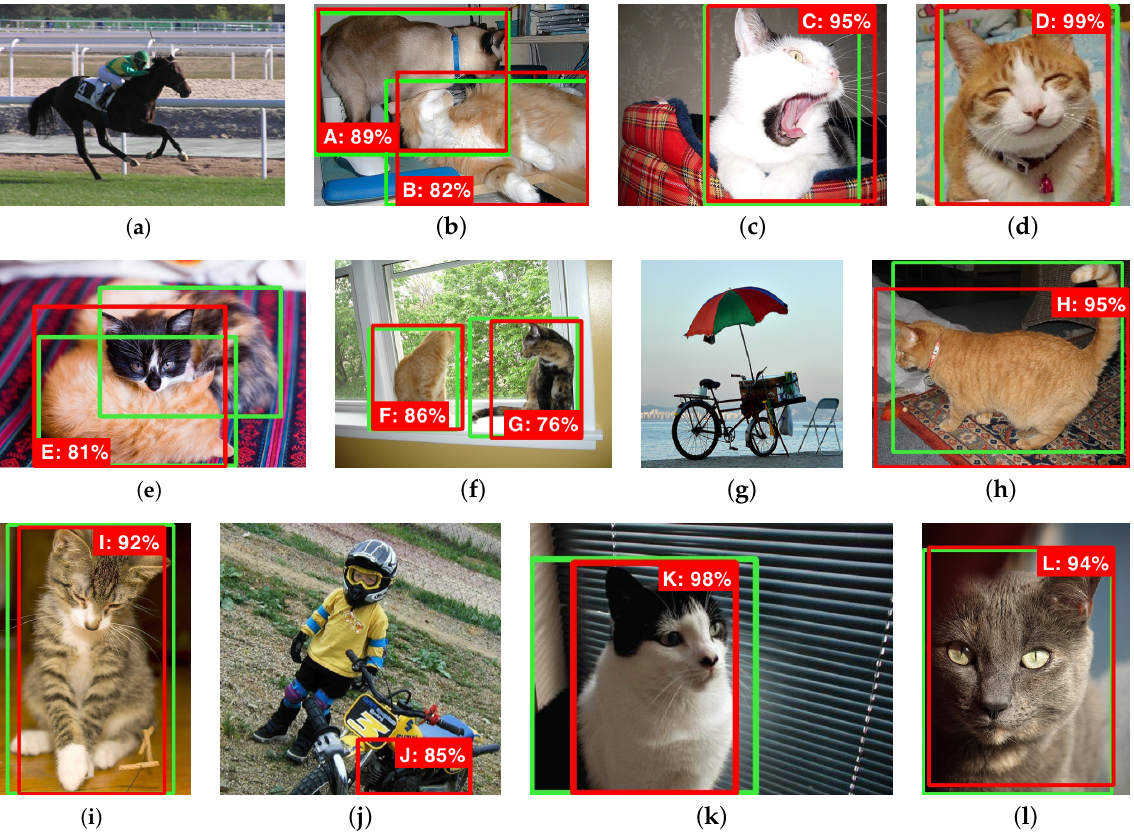
Figure 3. Samples of 12 images from the PASCAL VOC 2012 dataset [67] with ground-truth objects of the class cat in green boxes, and the detections performed by [9] in red boxes along with their respected confidence levels. In samples ( b – d , f , h , i , k , l ) the amount of the ground-truth and detected objects is the same. In samples of images ( a , g ), no ground-truth object should be detected but one false detection occurred in image ( j ). In sample ( e ) there are two target objects to be detected, but the detector missed one of